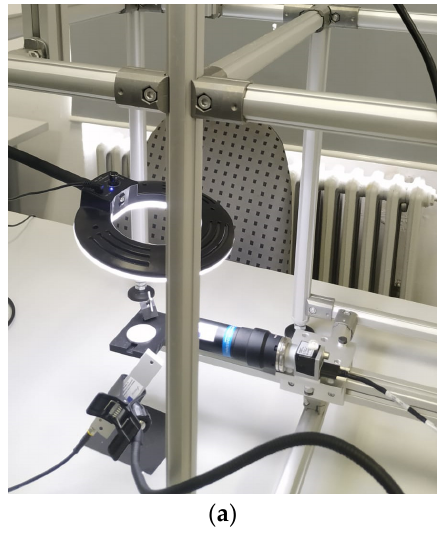
Figure 3. Reconfigurable measuring system: ( a ) Assembled RMS with lightning, stand, sensor, and measuring part; ( b ) Product in front of the telecentric lens placed in the special stand for taking the measure.